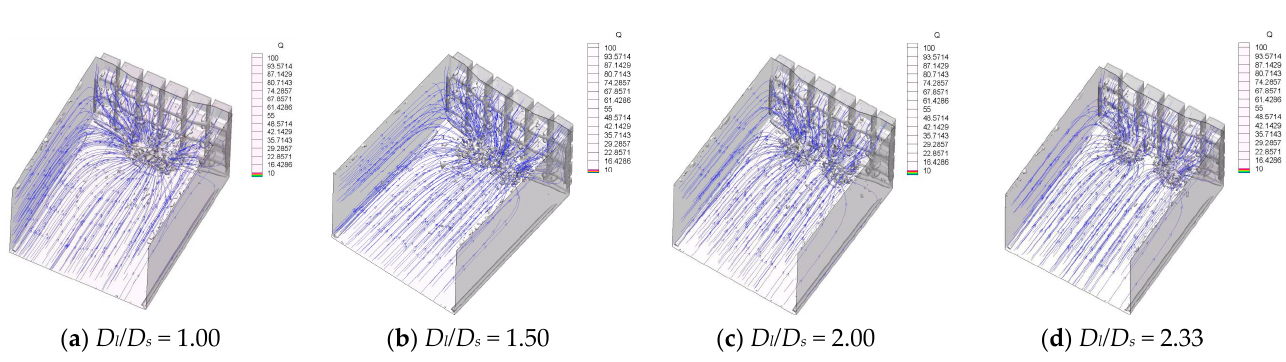
Figure 22. Suction sump three-dimensional vortex map (unit:s − 1 ).